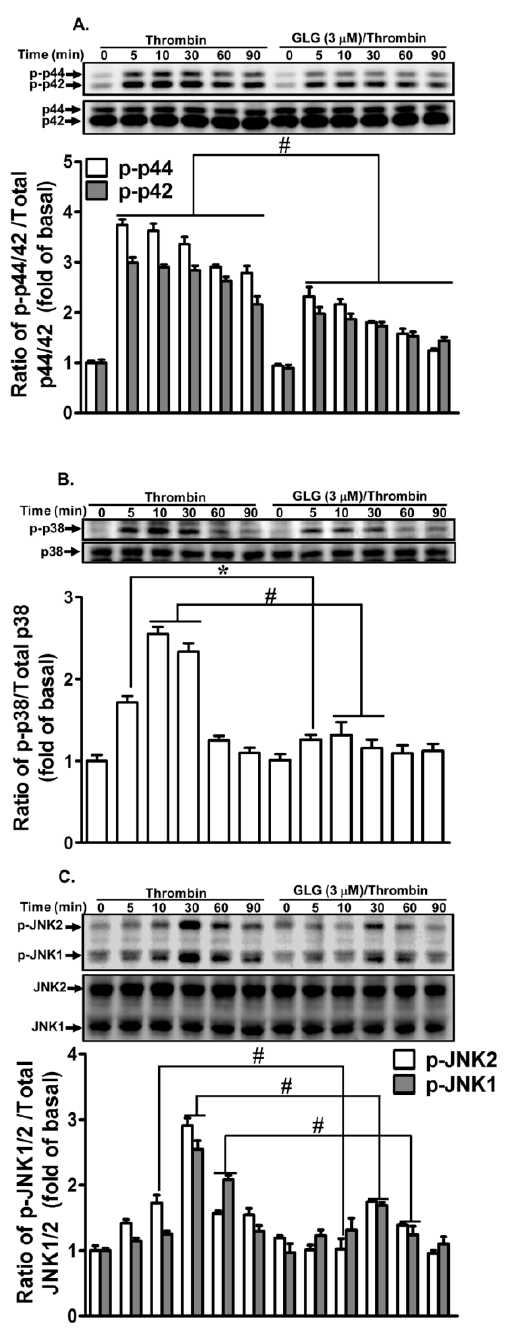
Figure 5. Galangin inhibits thrombin-induced phosphorylation of p42/p44 mitogen-activated protein kinase (MAPK), p38 MAPK, and Jun amino-terminal kinases (JNK)1/2. The cells were pretreated with galangin (3 µ M) for 1 h and then challenged with thrombin (10 U/mL) for the indicated time intervals. The levels of ( A ) p42/p44 MAPK, ( B ) p38 MAPK, and ( C ) JNK1/2 phosphorylation and their respective protein levels were determined by western blot. The data are expressed as mean ± SEM of three independent experiments. * p < 0.05; # p < 0.01, as compared with the cells exposed to thrombin